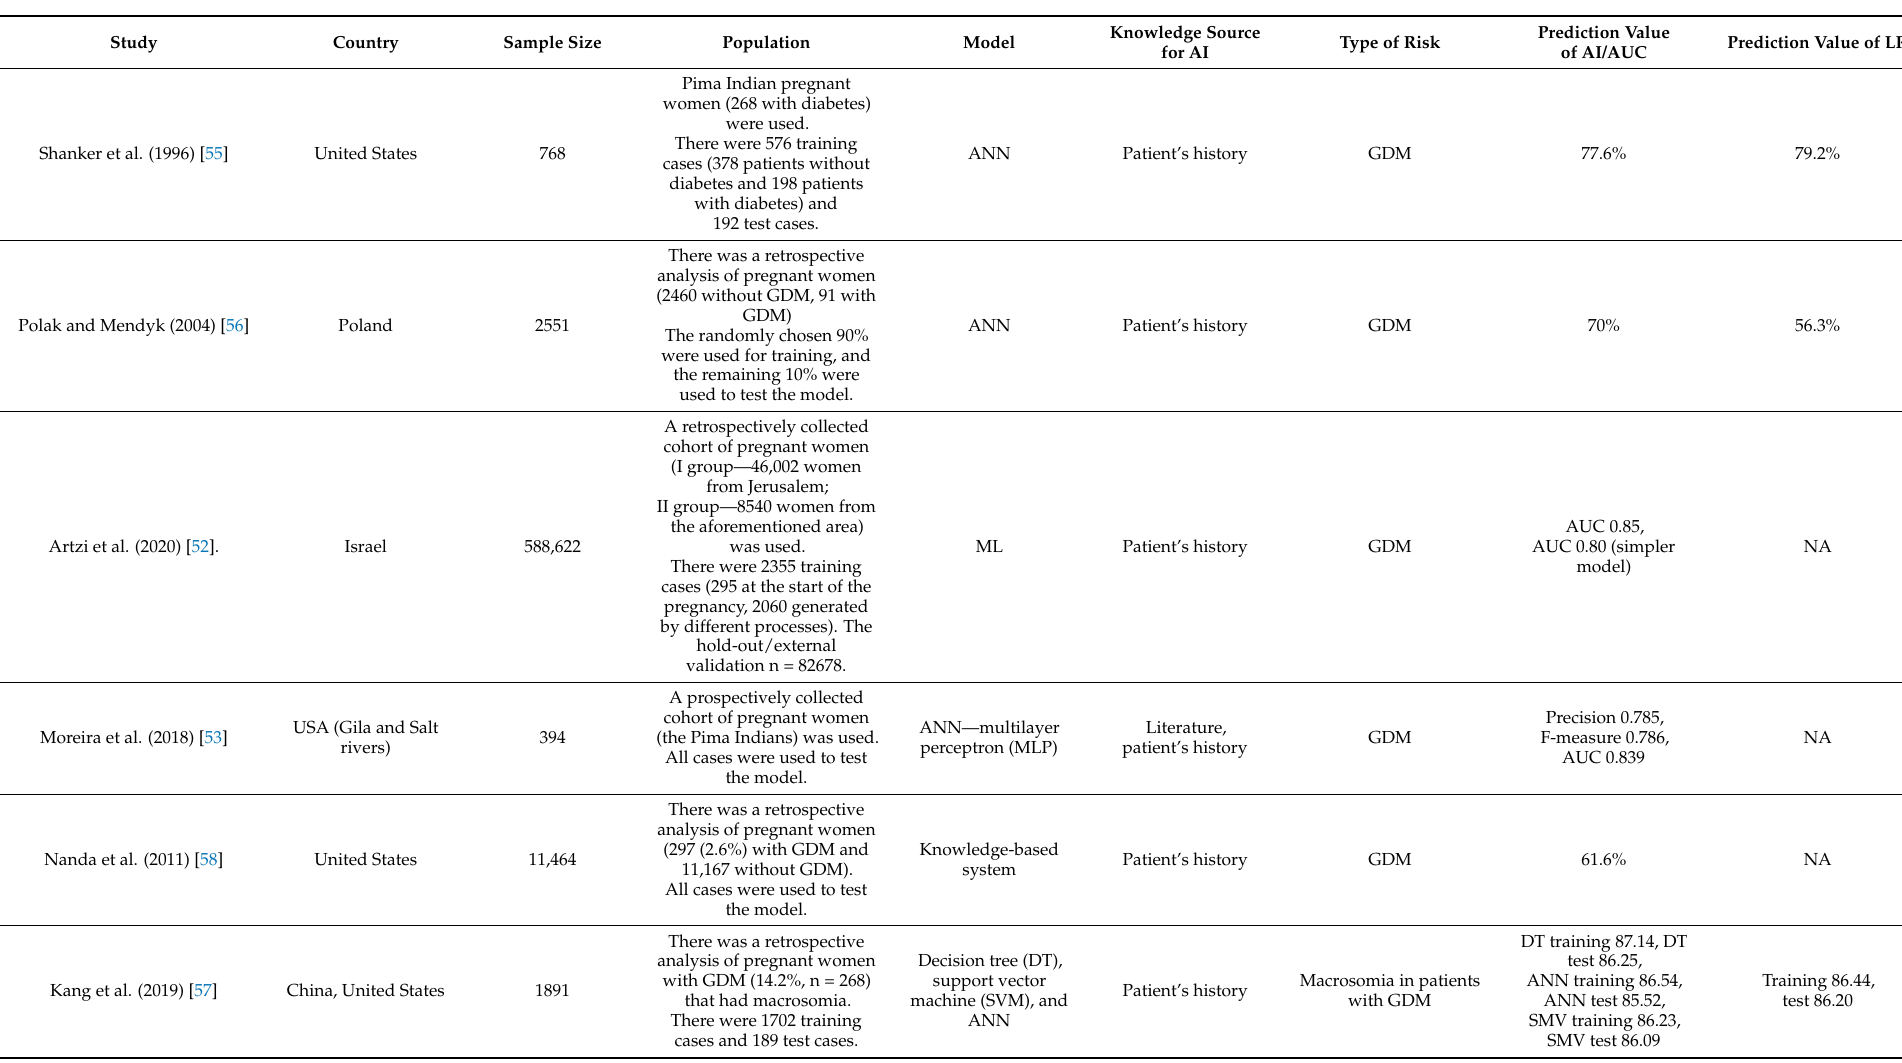
Table 7. Characteristics of included studies on gestational